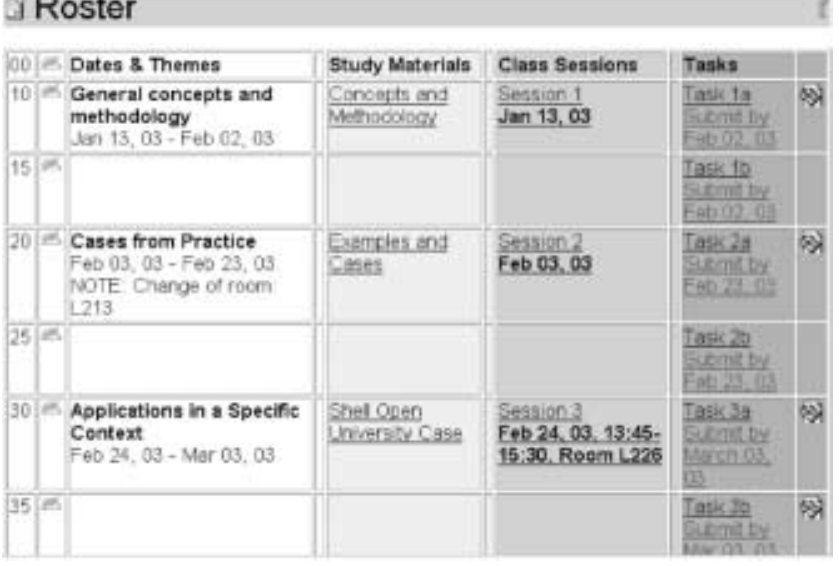
Figure 5. Options in tasks for students: Choose the ‘a’ or ‘b’